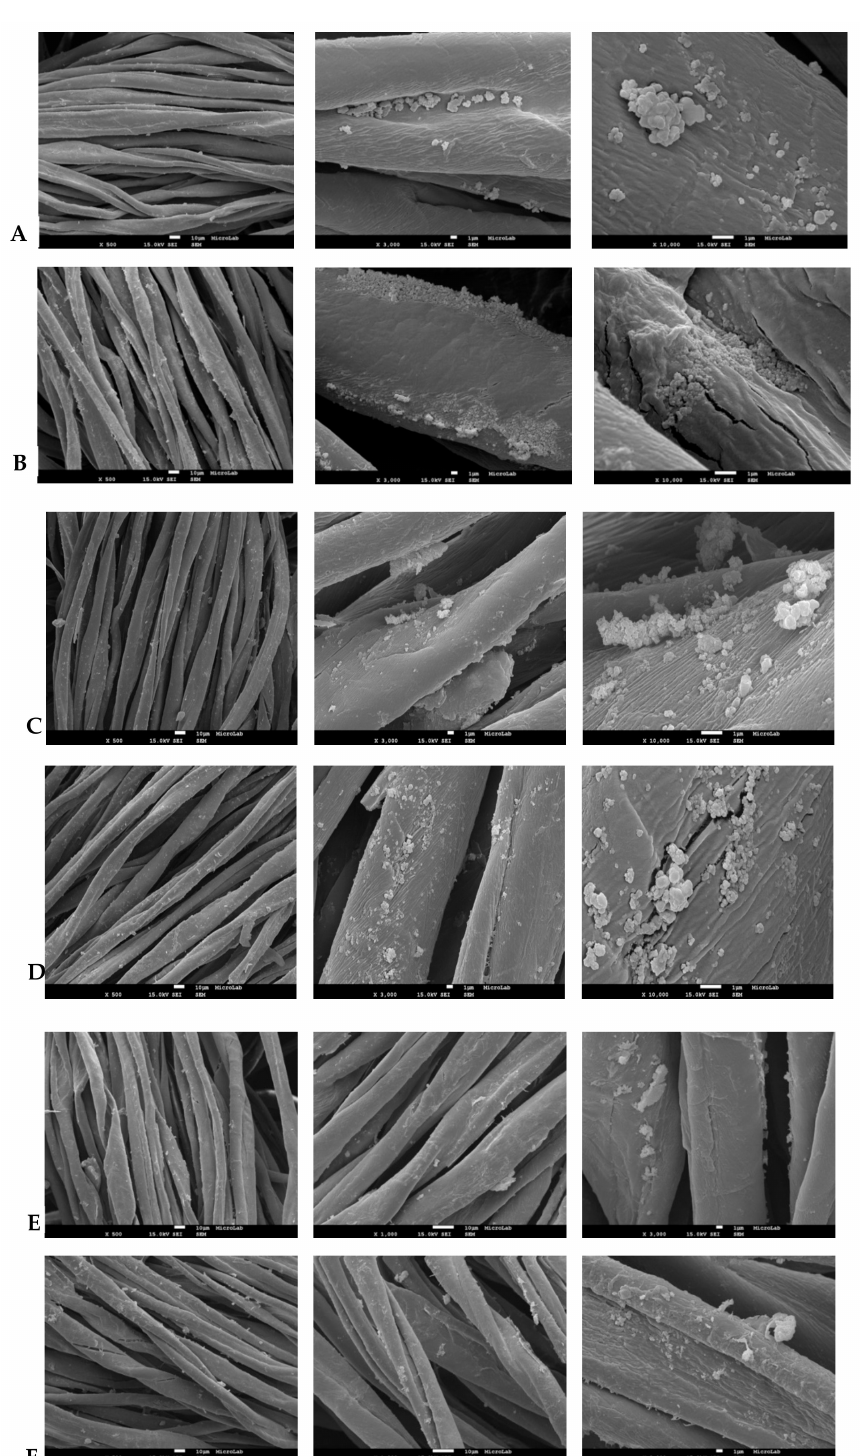
Figure 6. SEM images of cotton matrix impregnated with the following: a-TiO 2 NPs ( A -without cure; B -cured); a-TiO 2 -NH 2 NPs ( C -without cure; D -cured), and a-TiO 2 // CS NPs ( E -without cure; F